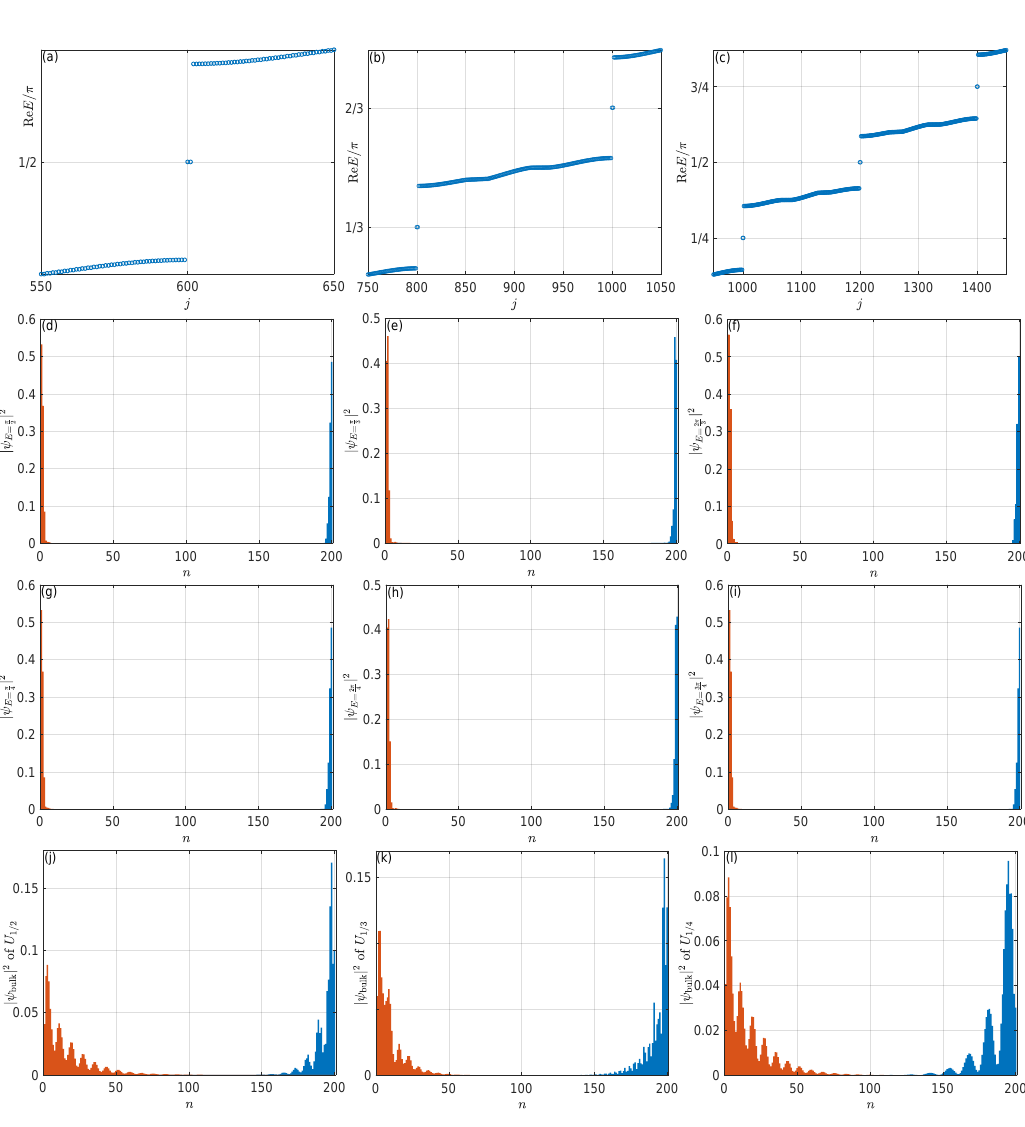
Figure 4: The real part of Floquet spectrum, fractional-quasienergy edge modes and bulk skin modes of the q th-root non-Hermitian FTIs for q = 2,3,4. j and n are state and unit cell indices. System parameters are ( J , J , µ , λ ) = ( π ,0.5 π ,0.4 π ,0.25 ) . 1 2 The length of lattice is L = 400. (a), (b) and (c) show the Floquet spectrum of U , U and U , zoomed in around E = π/ 2, E = ( π/ 3,2 π/ 3 ) and 1 / 2 1 / 3 1 / 4 E = ( π/ 4,2 π/ 4,3 π/ 4 ) , respectively. (d) shows the degenerate edge modes of U 1 / 2 with E = π/ 2. (e) and (f) show the degenerate edge modes of U with E = π/ 3 1 / 3 and 2 π/ 3. (g), (h) and (i) show the degenerate edge modes of U with E = π/ 4, 1 / 4 2 π/ 4 and 3 π/ 4. (j), (k) and (l) show three pairs of typical bulk states for U , U 1 / 2 1 / 3 and U , respectively, which are piled up around the boundaries and thus represent 1 / 4 non-Hermitian Floquet skin